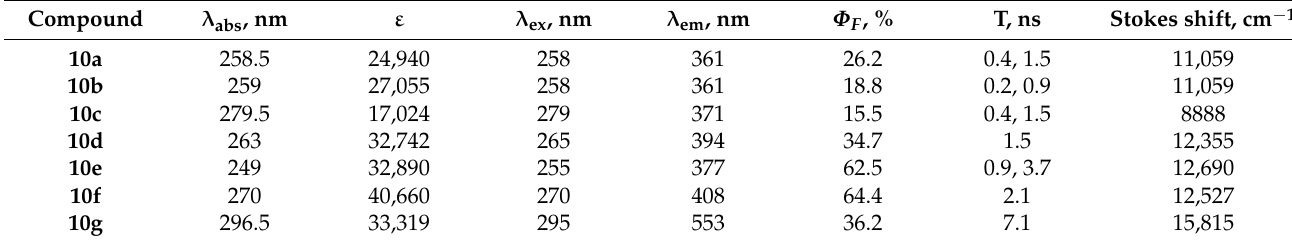
Table 1. Photophysical parameters of 10a – g (THF solutions).